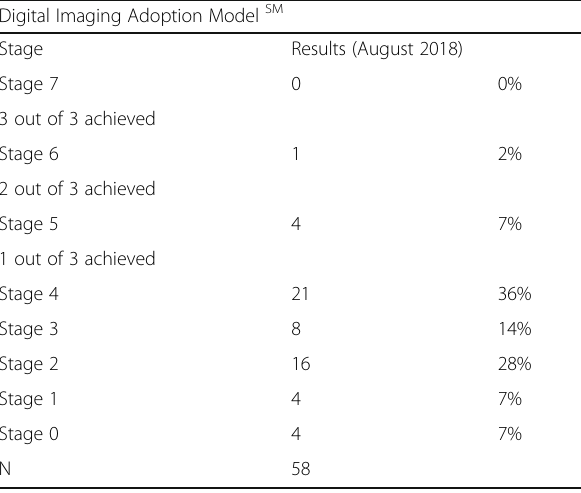
Table 2 DIAM scores by institution Digital Imaging Adoption Model